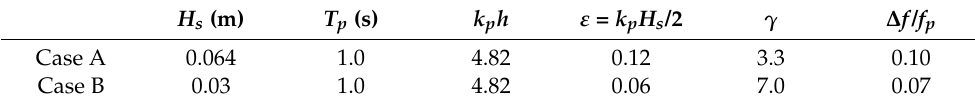
Figure 2. Experimental setup. Table 1. Wave parameters measured at the first location x = 5.0